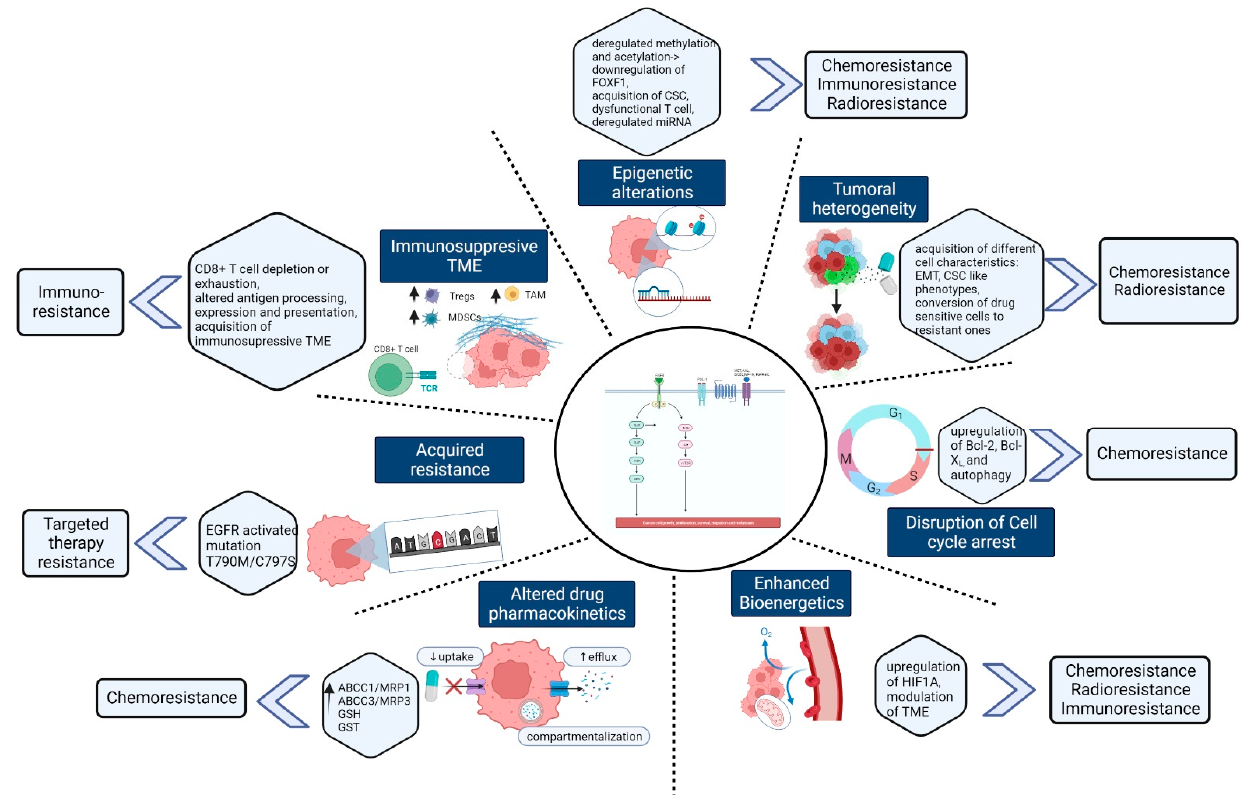
Figure 2. Different mechanisms inducing therapeutic resistance in lung cancer: Therapeutic resis- tance against chemotherapy, radiotherapy, targeted therapy, and immunotherapy in lung cancer is caused by different types of mechanism. For instance, tumor heterogeneity, alteration in drug influx and efflux, compartmentalization, epigenetic changes, hypoxia, or reduced autophagy stimulate chemoresistance in lung cancer. Radioresistance is found to happen by epithelial and mesen- chymal transition, DNA damage, dysregulated miRNA, and changes in various signaling pathways. Mutations in EGFR or KRAS genes and targets as well as alterations in drug sensitivity lead to mu- tations at T790M that cause primary and acquired resistance for targeted therapy. Mutations in can- cer driver genes, immunosuppressive TME, modified epigenetics, and high bioenergetic are mainly responsible for triggering immunoresistance in lung cancer (created with BioRender.com